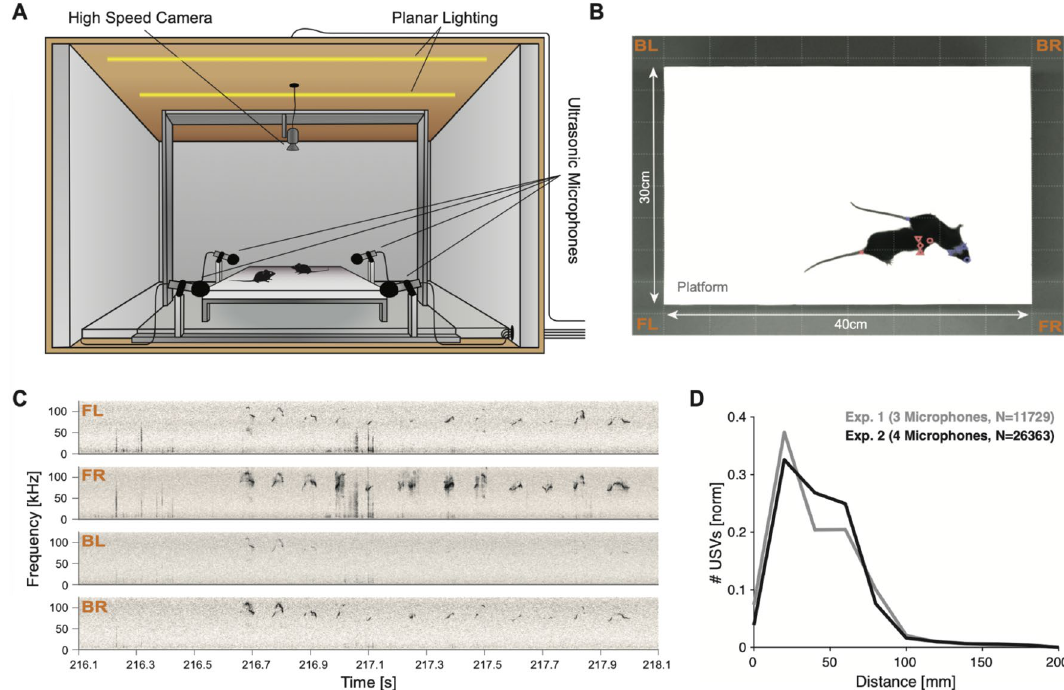
Figure 1. The study of mouse vocalizations during natural behavior requires attribution of individual vocalizations to individual mice. ( A ) A pair of female and male mice interacted freely on an elevated platform. Their spatial location, behavior and vocal production was monitored with a high-speed camera (placed directly above) and 4 ultrasonic microphones surrounding the platform. The whole setup was situated inside a sound- proof, ultrasonically anechoic box which was uniformly illuminated using a planar array of LEDs. ( B ) Animals were easily distinguishable against the white, anechoic platform. ( C ) Vocalizations occurred frequently during most experiments, in particular during social interaction of the animals (Frame in ( B ) at time = 217.1 s). ( D ) In the present paradigm, the majority of vocalizations were emitted when the animals were in rather close proximity (black: 4 microphone setup, gray: 3 microphone setup), typically below 10 cm snout-to-snout distance, shown on the